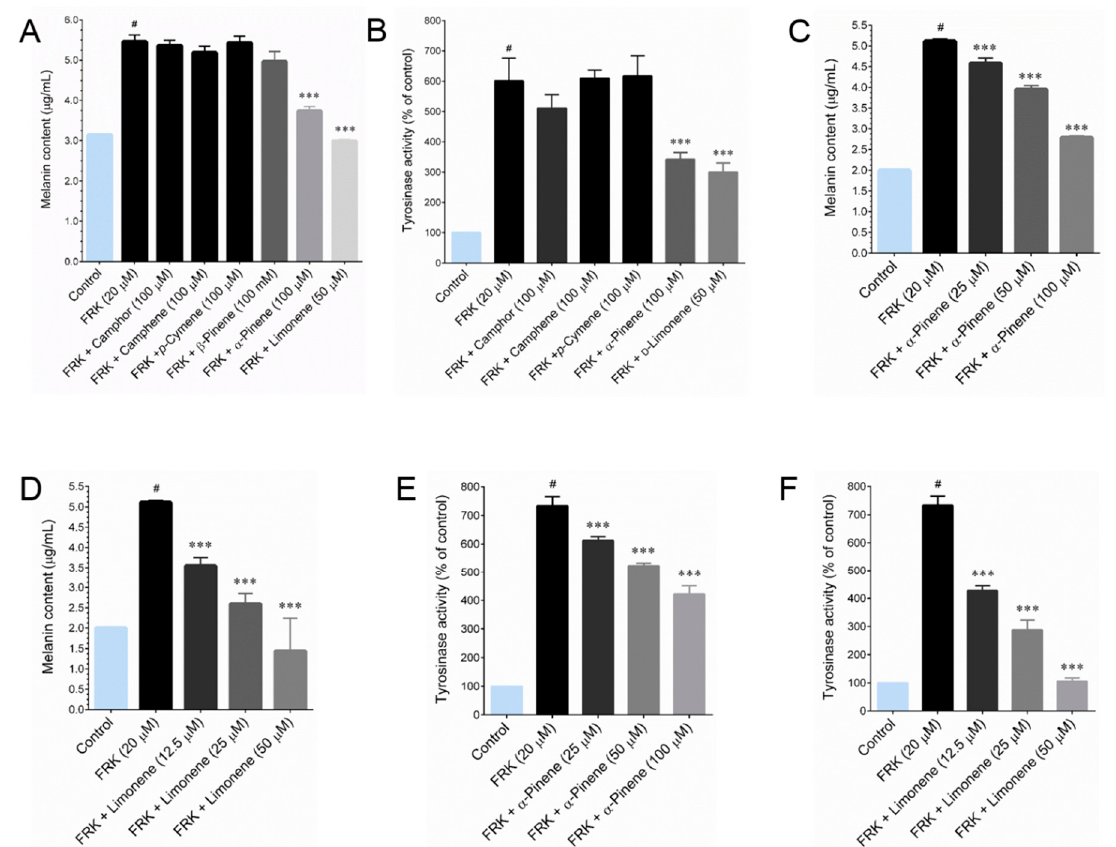
Figure 4. Effect of major compounds of LEO and REO on melanin production and cellular tyrosinase activity in FRK-stimulated cells. ( A ) Cells were treated with indicated concentration of major compounds and stimulated with FRK for 48 h. The melanin content was determined spectrometrically. ( B , C ) The effect of α -pinene and D-limonene on FRK-induced melanin production was determined in a dose-dependent manner. ( D ) The effect of cellular tyrosinase activity by major compounds of LEO and REO were determined. ( E , F ) Dose-dependent inhibitory effect of α -pinene and D-limonene were quantified. Data represent the mean ± SD of three experiments. Statistical significance was set at # p < 0.05 compared to control vs. FRK and *** p < 0.001 compared with FRK + sample treatment groups vs. control group.